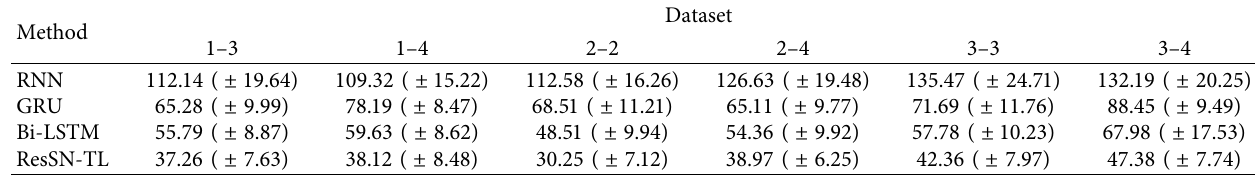
Table 4: RMSE results of hand-out cross validation.